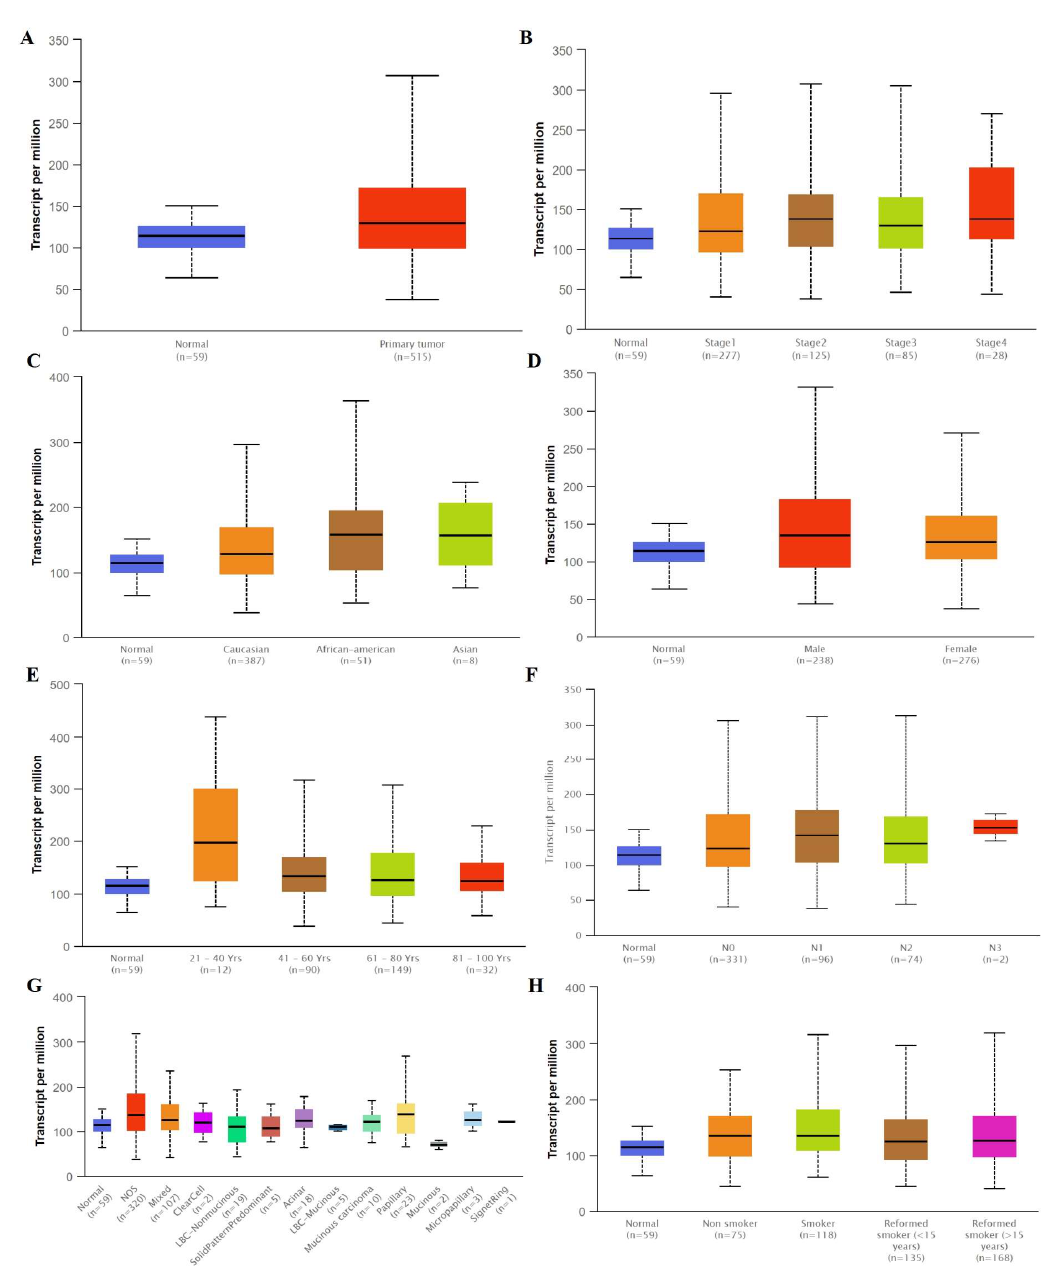
Figure 1. The mRNA level of SLC3A2 expressed in tumor tissues and in matched normal tissues from different subgroups of LUAD patients. ( A ) Sample type; ( B ) Stages; ( C ) Race; ( D ) Gender; ( E ) Age; ( F ) Nodel metastasis; ( G ) Tumor histology; ( H ) Smoking habits.